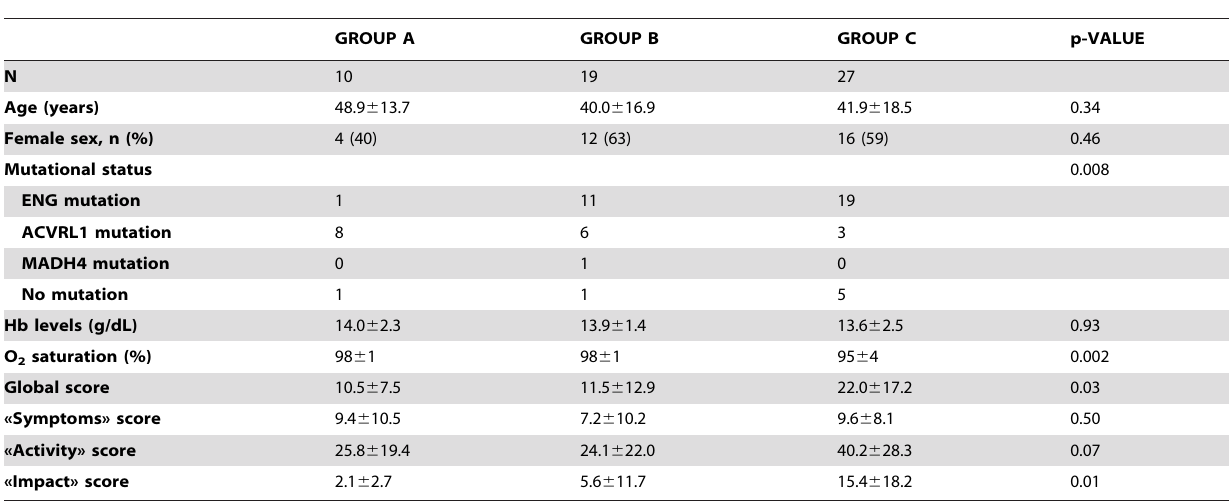
Table 1. Characteristics of the study participants.